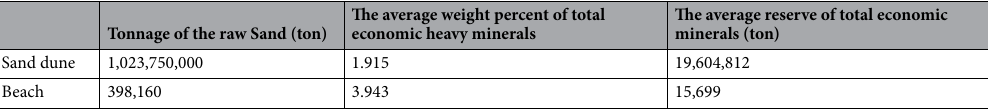
Table 8. The tonnage of total economic minerals in the studied area.